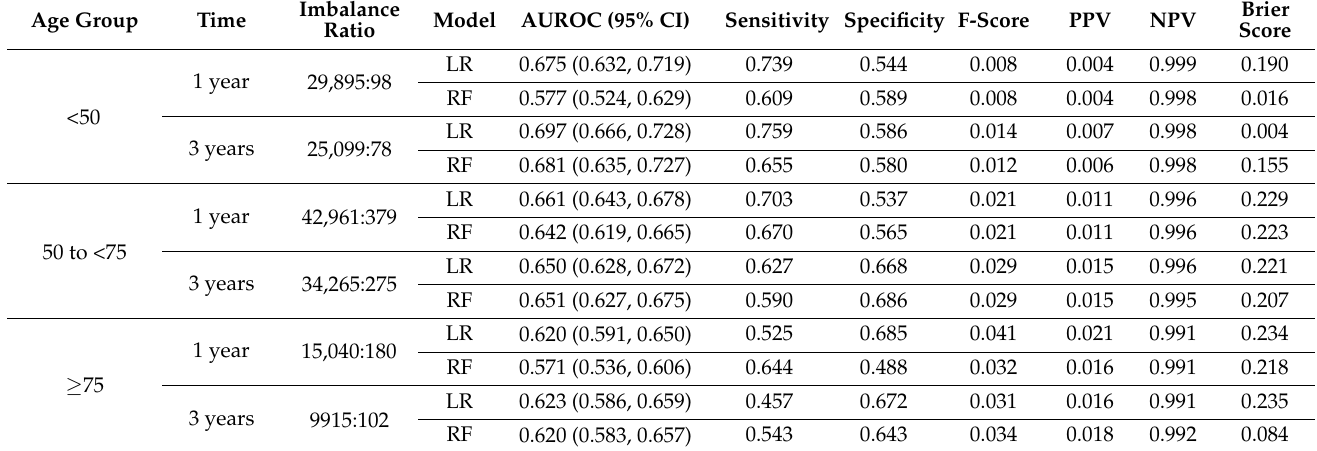
Table A1. Subanalysis by age. (AUROC = Area Under the Receiver Operating Curve, PPV = Positive Predictive Value, NPV = Negative Predictive Value, Imbalance Ratio = number of negative samples: number of positive samples, LR = Logistic Regression, RF = Random Forest).